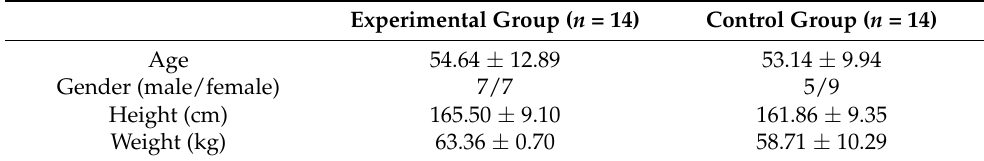
Table 1. Physical characteristics of the subjects ( n =